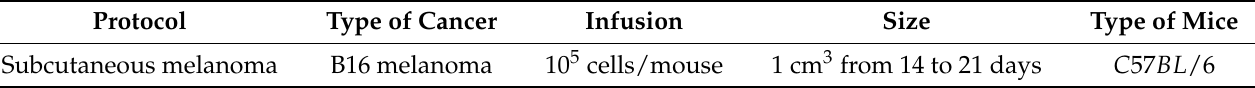
Table 1. Induction of melanoma in mouse